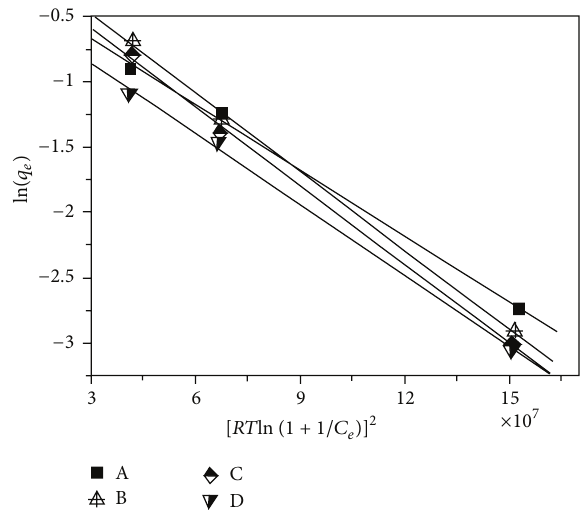
Figure 4: Plot of the D-R isotherm model for lead(II) adsorption on samples